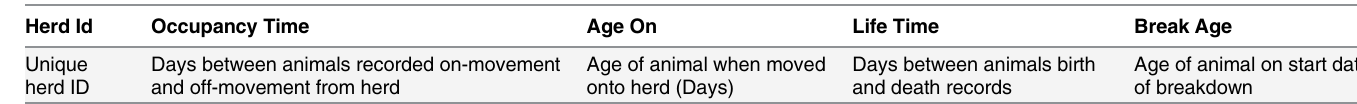
Table 9. Individual animal demographic data extract from cattle Tracing System (CTSTable). Herd